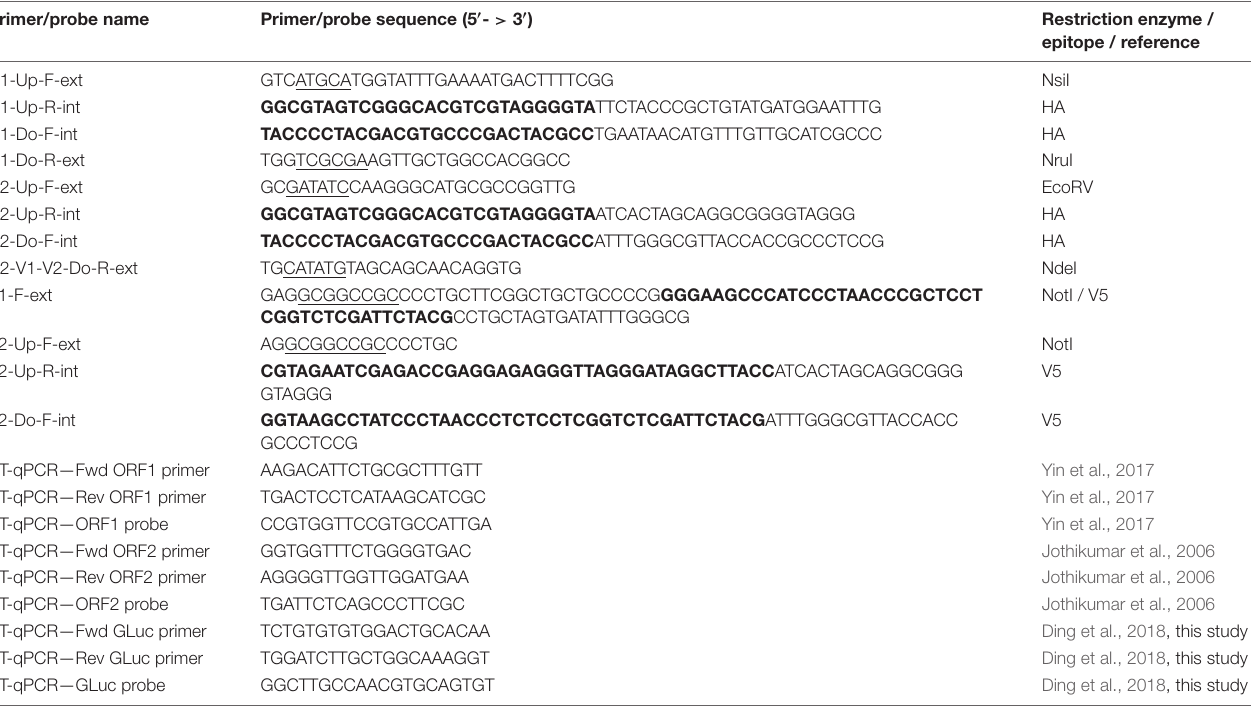
TABLE 1 | Sequences of primers and probes used to make the epitope tagged-ORF1 constructs and to quantify the genomic and subgenomic HEV RNAs by